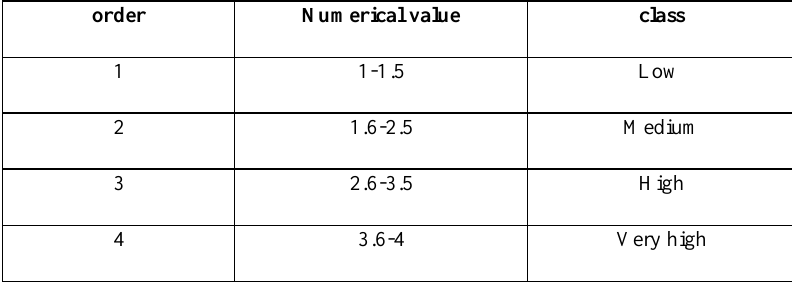
Table 1. Intensity classification of desertification